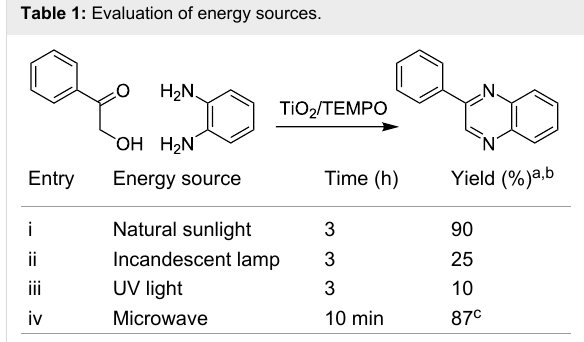
Table 1: Evaluation of energy